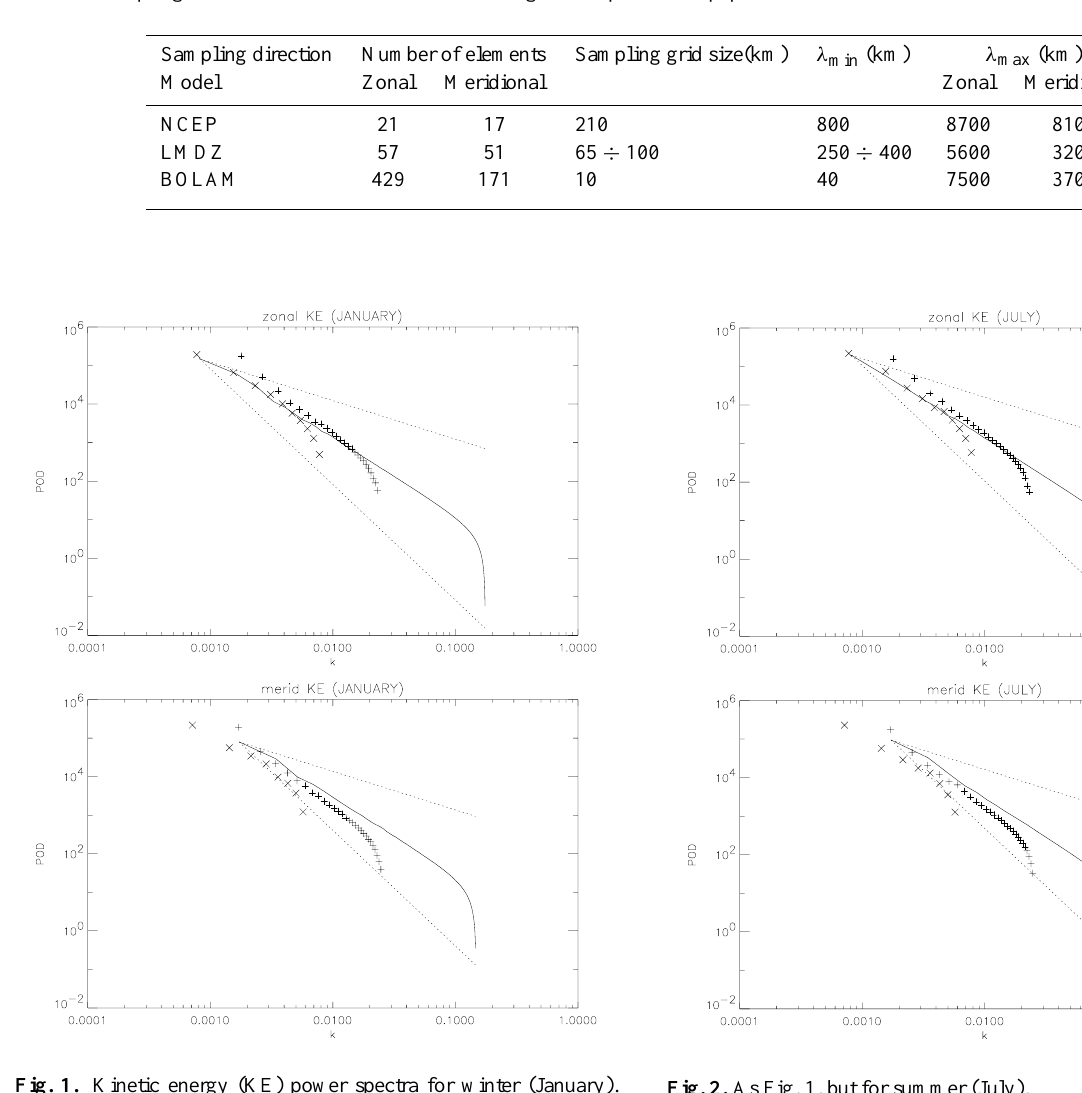
Table 1. Sampling characteristics of the three numerical grids adopted in the paper.